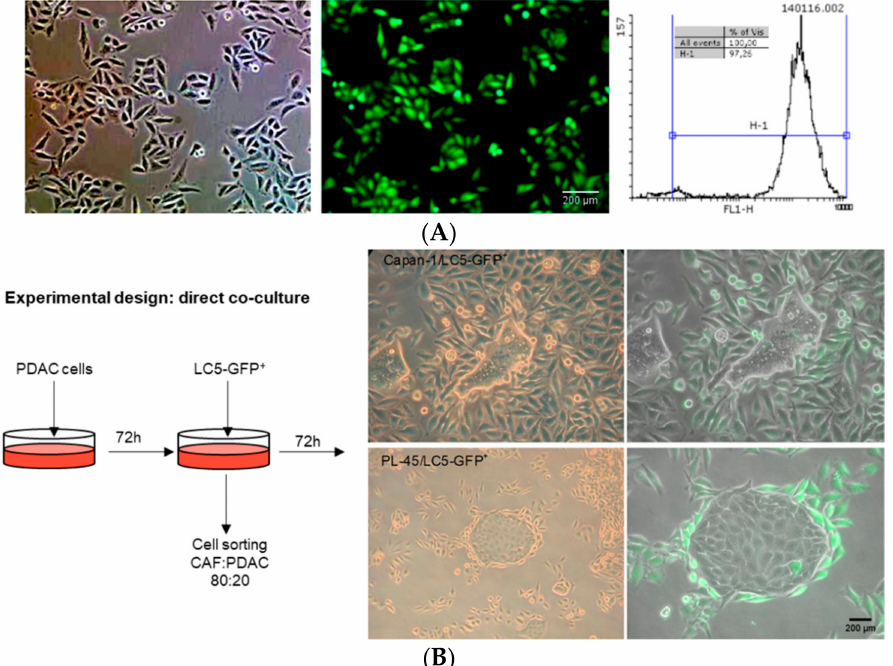
Figure 1. Photographs of phase contrast and fluorescence microscopy of the selection of fibroblast LC5-GFP + after FACS sorting. The percentage of GFP expressing fibroblasts was higher than 97% ( A ). Strategy scheme of direct cocultures: representative images at 72 h of pancreatic tumor cells (Capan-1 or PL-45) and fibroblast LC5-GFP + ( B ). Green cells are GFP-transfected